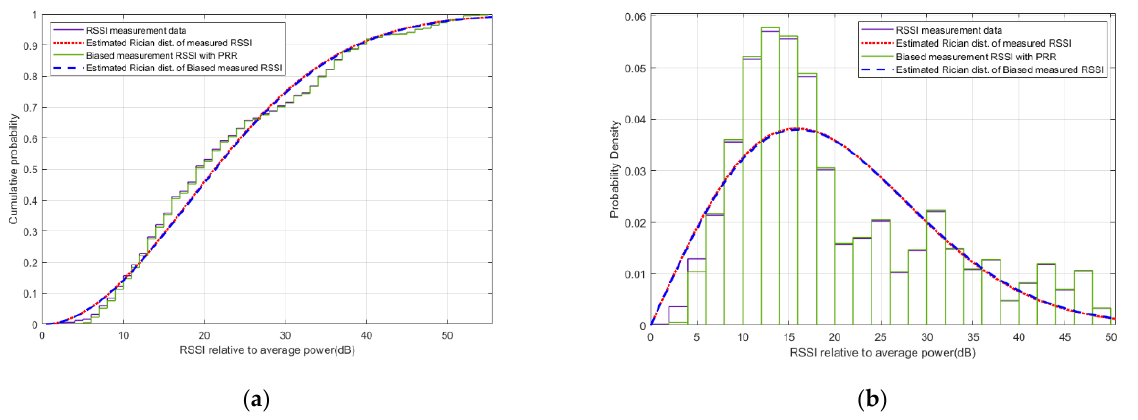
Figure 7. ( a ) CDF and ( b ) PDF of conventional and biased Wi-SUN channel approximation (2FSK- 433-50 alias).